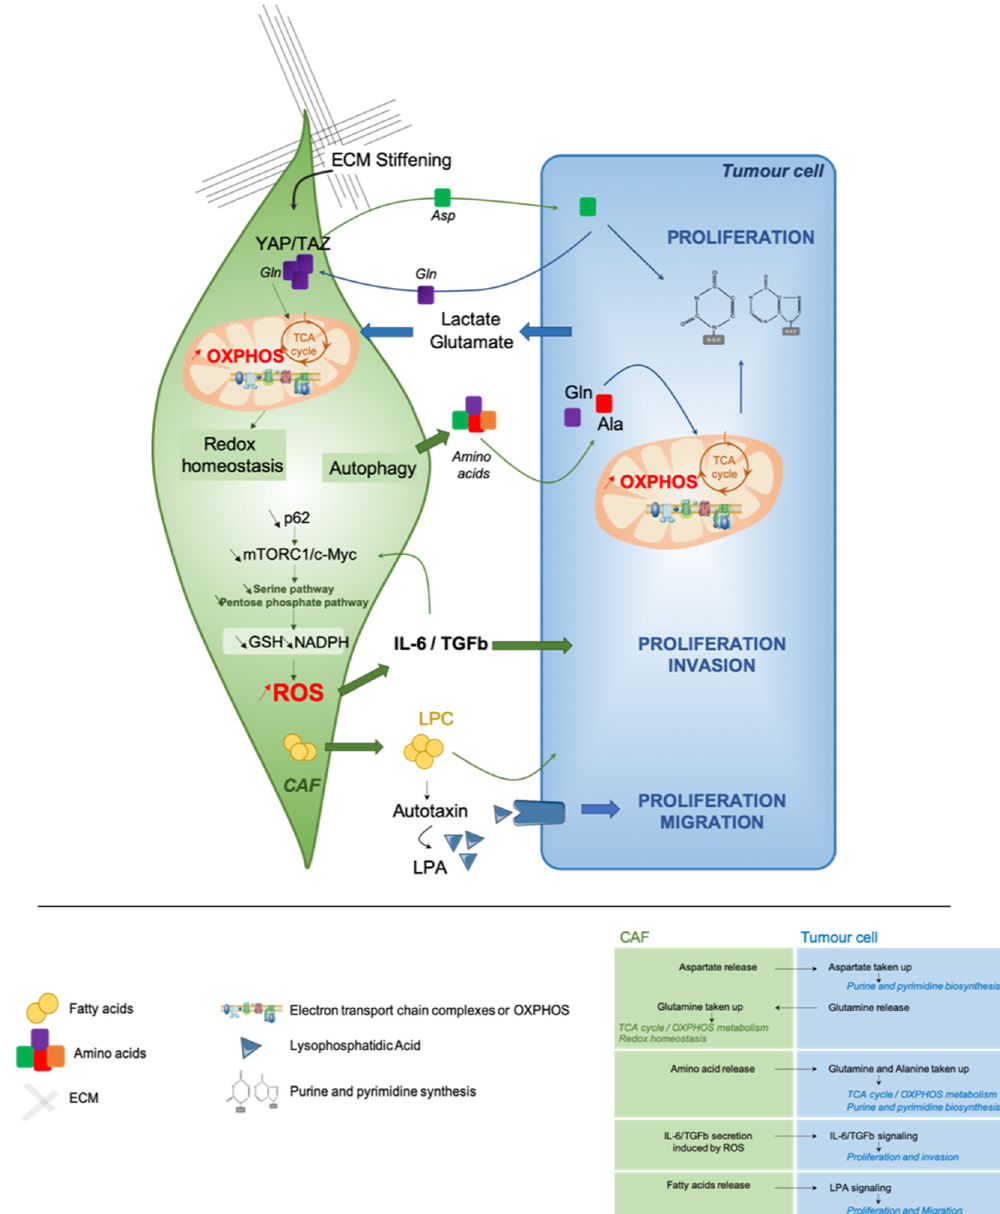
Figure 2. Metabolic crosstalk between CAF and tumor cells. CAF have the ability to support cancer cell growth, proliferation and migration/invasion by different metabolic mechanisms involving extra cellular matrix (ECM) stiffening, redox homeostasis, autophagy and lipid secretion. ECM stiffening, through YAP/TAZ signaling promotes glutamine taken up by CAF to fuel the TCA cycle and to maintain redox homeostasis and aspartate release. Autophagy results in the release of amino acids, such as glutamine (Gln) and alanine (Ala), which can be taken up and used by cancer cells to replenish the TCA cycle and OXPHOS metabolism. Decrease mTORC1/cMYC signaling in CAF reduces serine and pentose phosphate pathways leading to a redox imbalance. Therefore, increasing reactive oxygen species (ROS) accumulation and the secretion of IL-6 and TGF β in the microenvironment. This secretion promotes cancer cell proliferation and invasion. CAF release lipids, including lysophosphatidylcholines (LPC) into the microenvironment. LPC can be converted to lysophosphatidic acid (LPA) by extracellular autotaxin. LPA induces cancer cell proliferation and migration through the LPA receptors on cancer cells. The arrows represent the metabolites secreted or released by CAF (green) or tumor cells (blue). GSH: Reduced